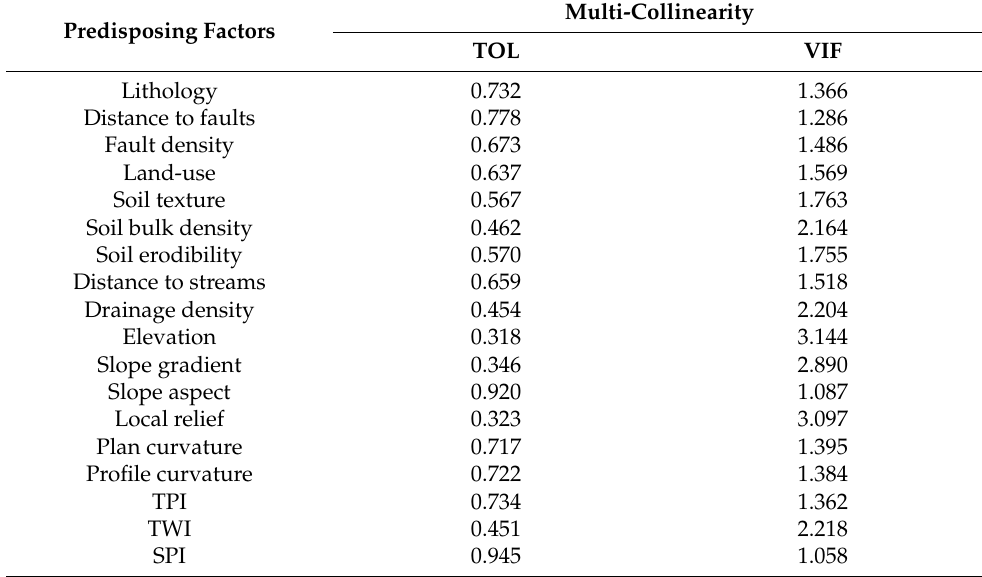
Table 4. Results of the multi-collinearity analysis between the predisposing